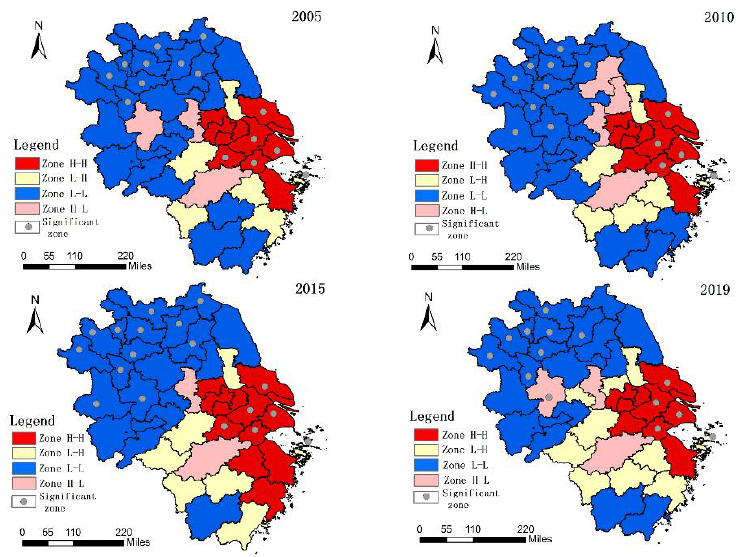
Figure 6. The LISA chart of the level of open economy in YRDA in 2005, 2010, 2015, and 2019. As a whole, the local spatial autocorrelation of the development level of open economy in the YRDA is mainly dominated by the H-H and L-L districts, and spatial homogeneity is more prominent than spatial heterogeneity. In terms of spatial distribution, the spatial scope of the H-H area has an expanding trend and is mainly distributed in the middle and southeast of the Yangtze River Delta; the L-L region has evolved from agglomeration in the northwest of the YRDA to agglomeration in the west and north. The spatial distribution of the L-H and H-L regions is scattered, mainly in the south and middle. In space, the distribution pattern of “prominent in the middle, high in the south, low in the north, high in the east and low in the west” is